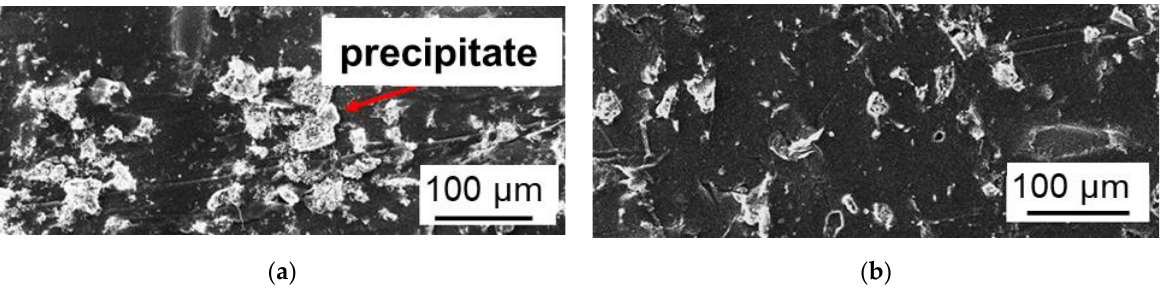
Figure 10. SEM images of the MA-41P membrane surface facing the desalination compartment after ED demineralization of a multicomponent solution in CC2 ( a ) and PEF ( b ) modes.